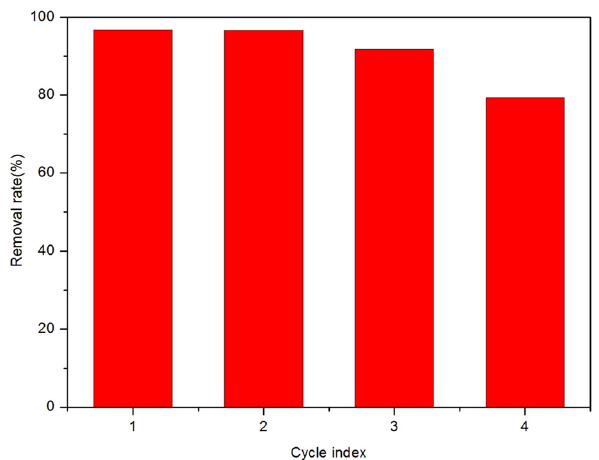
Figure 4: Reuse of Sm - MOF adsorbed